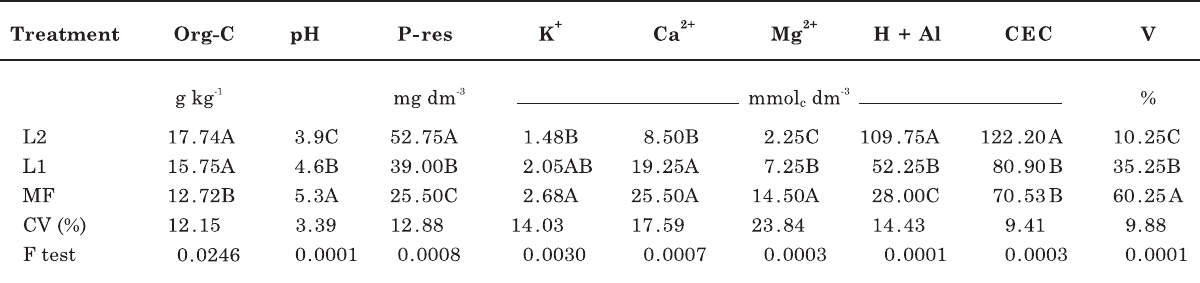
Table 3. Soil chemical attributes at 0–0.20 m depth layer after addition of sewage sludge (SS) (L1 = 10 t ha -1 and L2 = 20 t ha -1 ) and mineral fertilizer